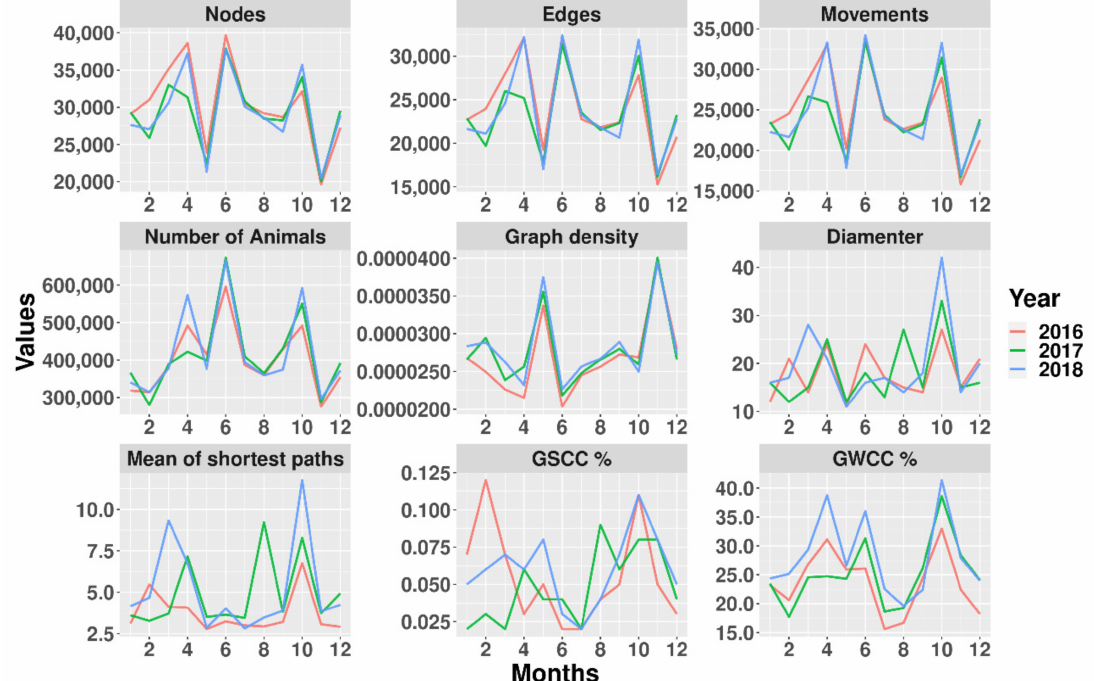
Figure 4. Description of the network using a time-aggregate windows of 30 days from the parameters: nodes, edges, movements, number of animals, graph density, diameter, mean of the shortest paths, GSCC, and GWCC. The description of parameters are shown in Table